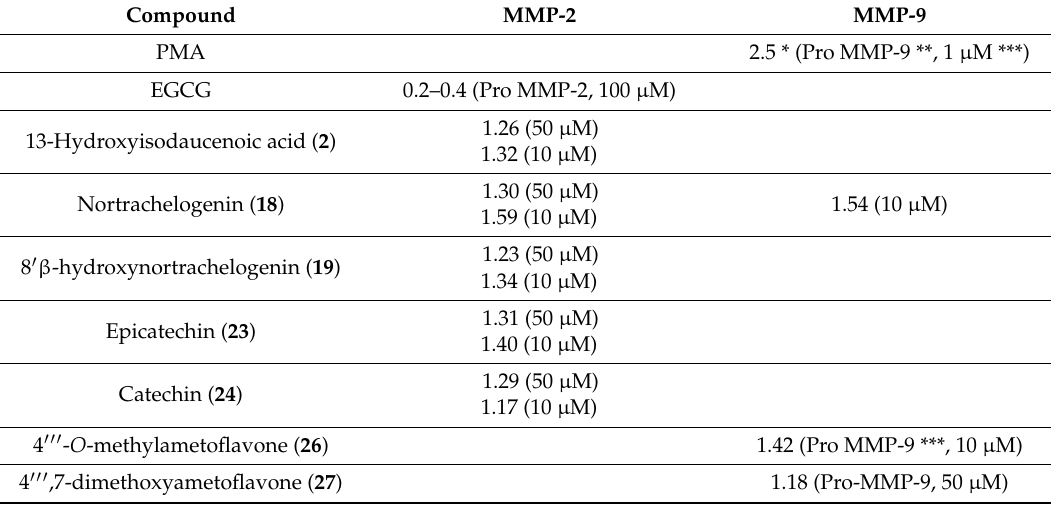
Table 2. Compounds that modulate matrix metalloprotease 2 (MMP-2) and MMP-9 expression to various